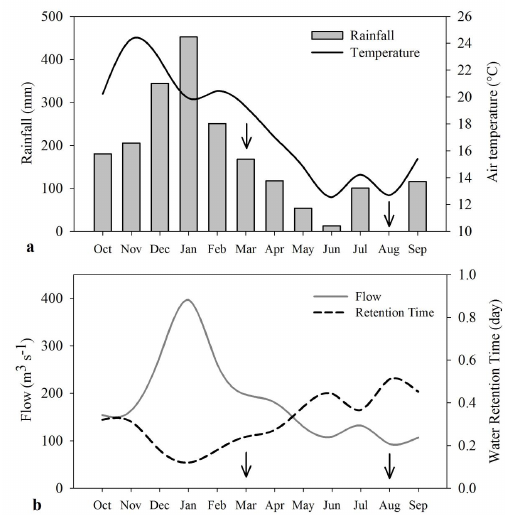
Figure 2. Total accumulated rainfall and average monthly air temperature ( a ) and average flow and water retention time ( b ) of the Rasgão reservoir (period: October 2009 to September 2010). The arrows indicate the sampling months. + N-NO + N-NH 2 3 4